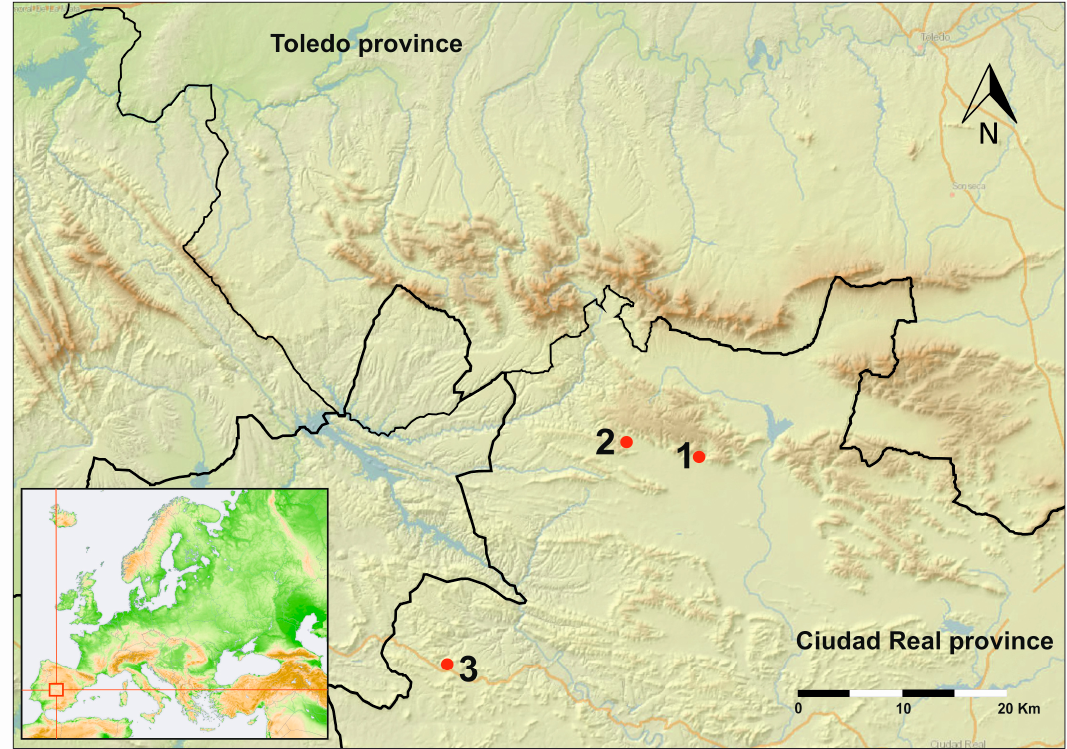
Figure 1. Map of the Toledo Mountains in central Spain with location of the selected peatlands (red dots): 1 . Brezoso [42,43]; 2 . Viñuelas [43]; 3 . El Perro [this paper].